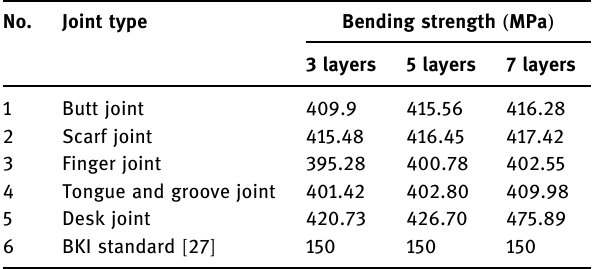
Table 11: Comparison of the results of the bending strength test with the BKI